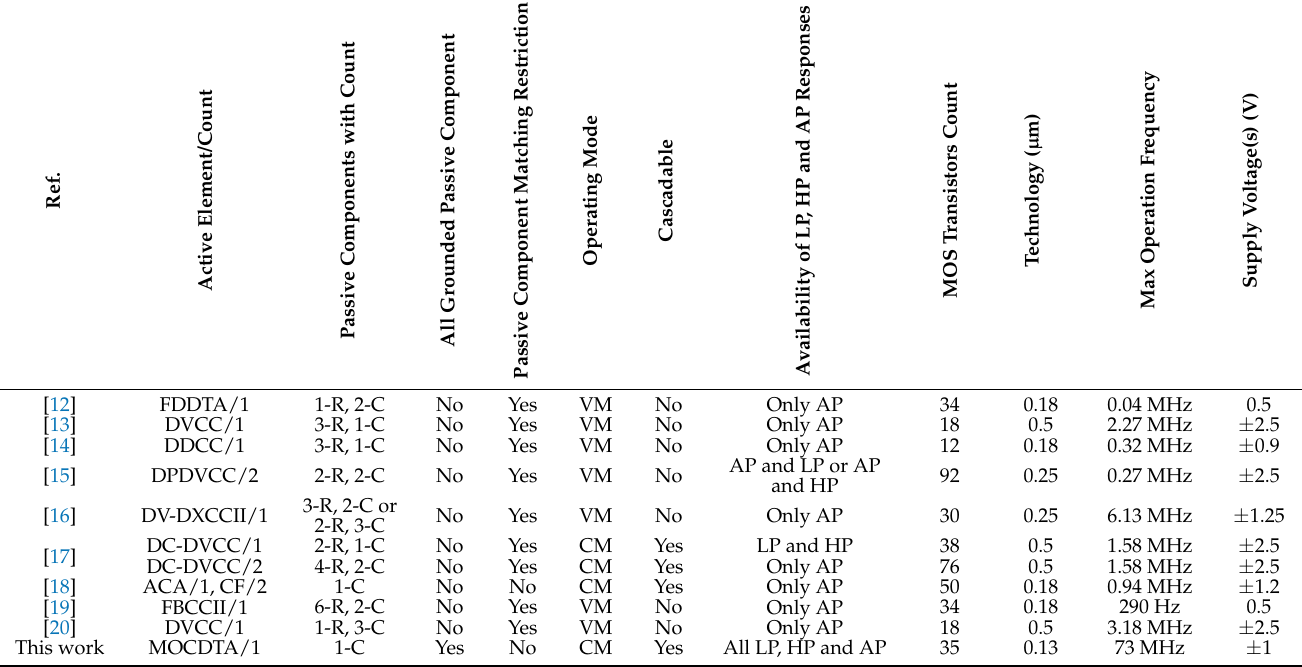
Figure 10. Monte Carlo simulation results for the variation in threshold voltages: ( a ) histogram for maximum amplitude; ( b ) histogram for pole frequency. Table 3. Comparison among the proposed fully differential first-order circuit and earlier reported fully differential first-order circuits.